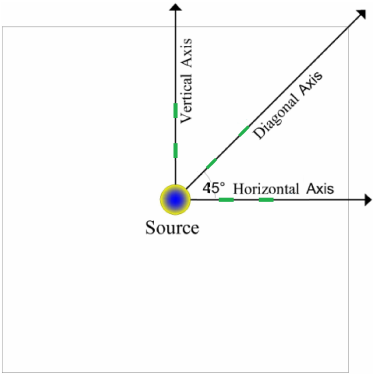
Figure 2. Plan view of the initial wave and axis for the uniform bottom domain. Green lines represent gauges along the axis.